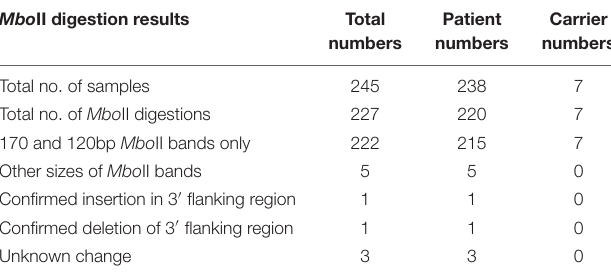
TABLE 1 | Summary of Mbo II digestion